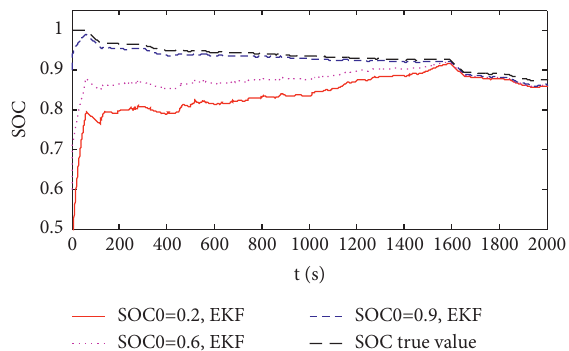
Figure 7: The convergence speed of EKF under different SOC